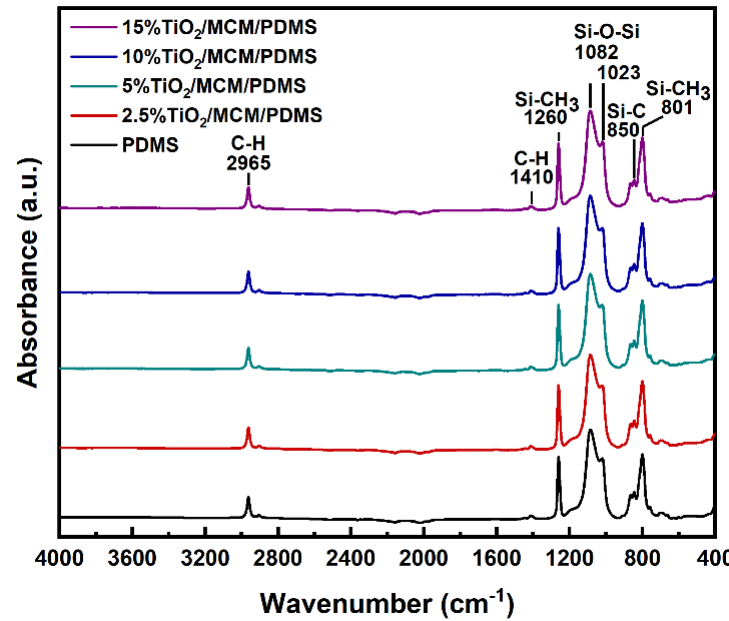
Figure 1. FTIR spectra of pristine PDMS and TiO 2 /MCM/PDMS composites.